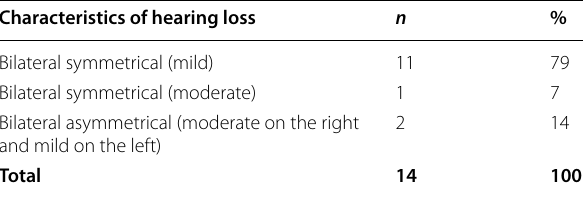
Table 2 Clinical and audiometric data of workers Table 3 Audiometric characteristics of hearing